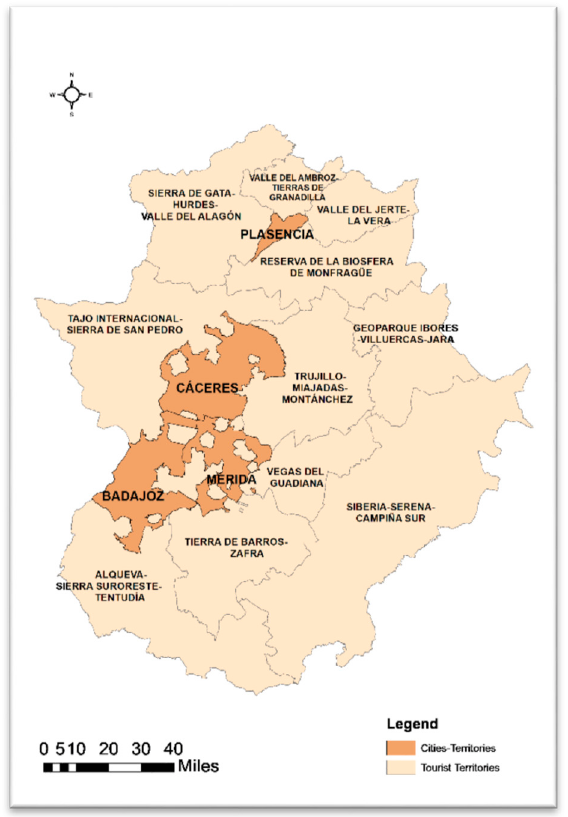
Figure 2. Maps of tourist territories of Extremadura.